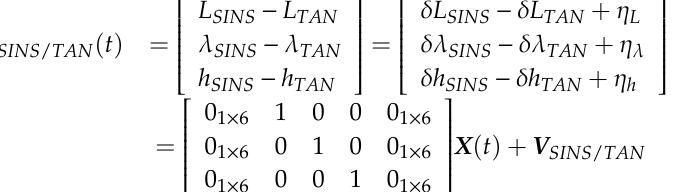
Figure 4. The real picture of the strapdown inertial navigation system (SINS). Figure 5. The real picture of the odometer.